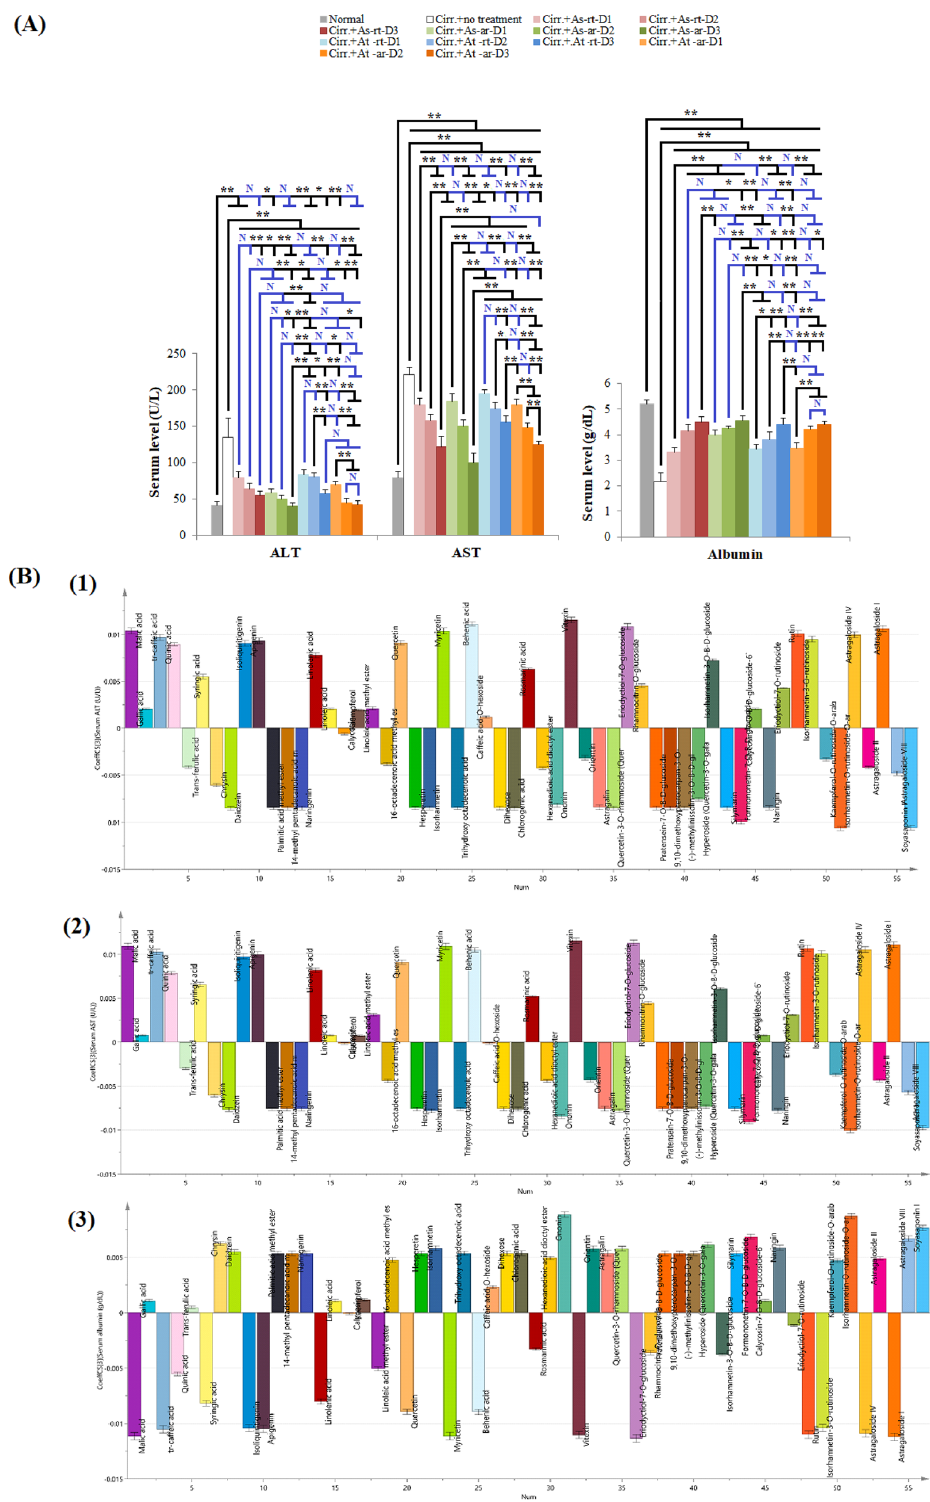
Figure 5. The effect of different Astragalus extracts on serum markers of hepatocytes integrity and liver synthetic function and their coefficient plot of OPLS model. ( A ): Comparison between different groups according to serum markers of hepatocytes integrity and liver synthetic function, ( B ): Coefficient plot of OPLS model for serum markers of hepatocytes integrity and liver synthetic function; (1) ALT (2) AST (3) albumin. ANOVA test was used to compare between the different groups with Post Hoc Test (Tukey) to compare different groups. *: Statistically significant at p ≤ 0.05, **: Statistically significant at p ≤ 0.001, N: Statistically non-significant ( p > 0.05), n = 8; all results are presented as mean ± SD. (Cirr.: induced cirrhosis by i.p. administration of CCl 4 (diluted 1:6 with mineral oil) as follows: The first 10 doses were received every 5 days, the subsequent 10 doses were administered every 4 days, and the last 7 doses were given every 3 days, As: Astragalus spinosus , At: Astragalus trigonus , ar: aerial organs, rt: root organs, D1: low dose, D2: medium dose, D3: high dose, ALT: Alanine aminotransferase and AST: aspartate